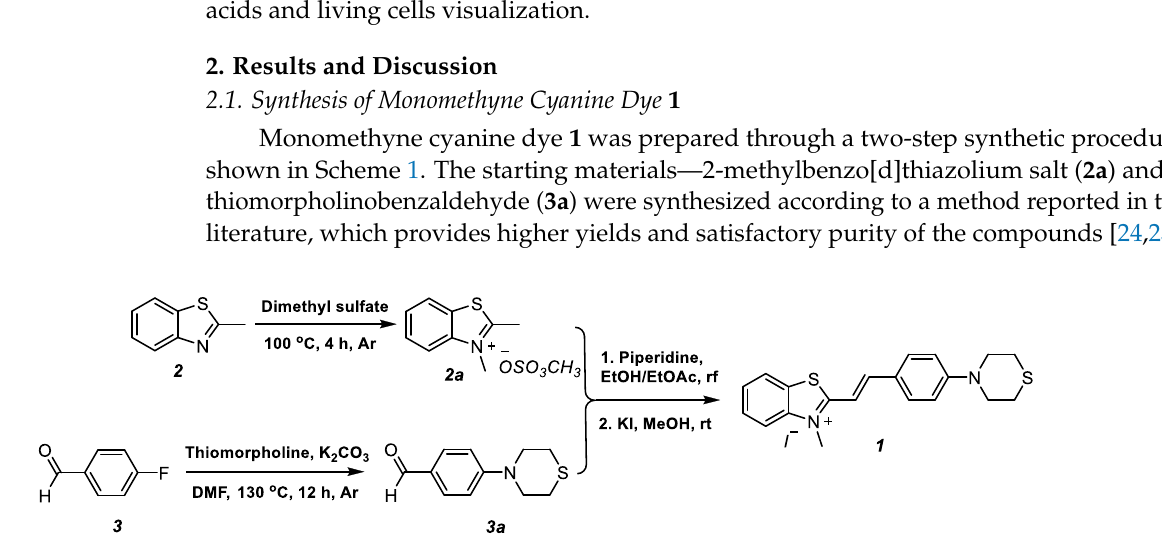
Figure 2. Fluorescence of dye 1 with cell organelles in stem cells from apical papilla. 3. Materials and Methods 3.1. General All reagents and solvents are commercially available and used as supplied. The 2,3- Dimethylbenzo[ d ]thiazol-3-ium methyl iodide ( 2a ) [24] and 4-thiomorpholinobenzalde- hyde ( 3a ) [24] were synthesized starting from 2-methyl benzo[ d ]thiazole ( 2 ) and 4-fluoro- benzaldehyde ( 3 ), respectively, according to the previously published research methods in the literature [25]. The progress of the chemical reactions was monitored by thin layer chromatography (TLC) ALUGRAM ® SIL G/UV 254-60 Macherey-Nagel, ready-to-use plates with thickness of the silica layer at 0.2 mm. Melting points of 1 , 2a and 3a were determined on Kruess M5000 melting point meter for automatic measurements. NMR spectra ( 1 H-, 13 C-NMR) were obtained on a Bruker Avance II+ NMR spectrometer operat- ing at 500 MHz for 1 H- and 125 MHz for 13 C-NMR in DMSO-d 6 as a solvent (Supplemen- tary Materials). The chemical shifts are given in ppm ( δ ) using tetramethylsilane (TMS) as an internal standard. The mass spectra of dye 1 was obtained on an Advion expression CMS mass spectrometer in “High temperature and low fragmentation” regime and ana- lyzed by using Advion CheMS Express software version 5.1.0.2. IR spectra is obtained on Specord 71 (Carl-Zeiss Jena) spectrometer in Nujol as a solvent. UV-VIS spectra were